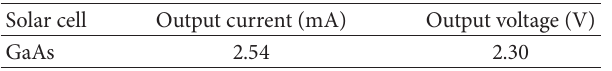
Table 1: The output property of GaAs solar